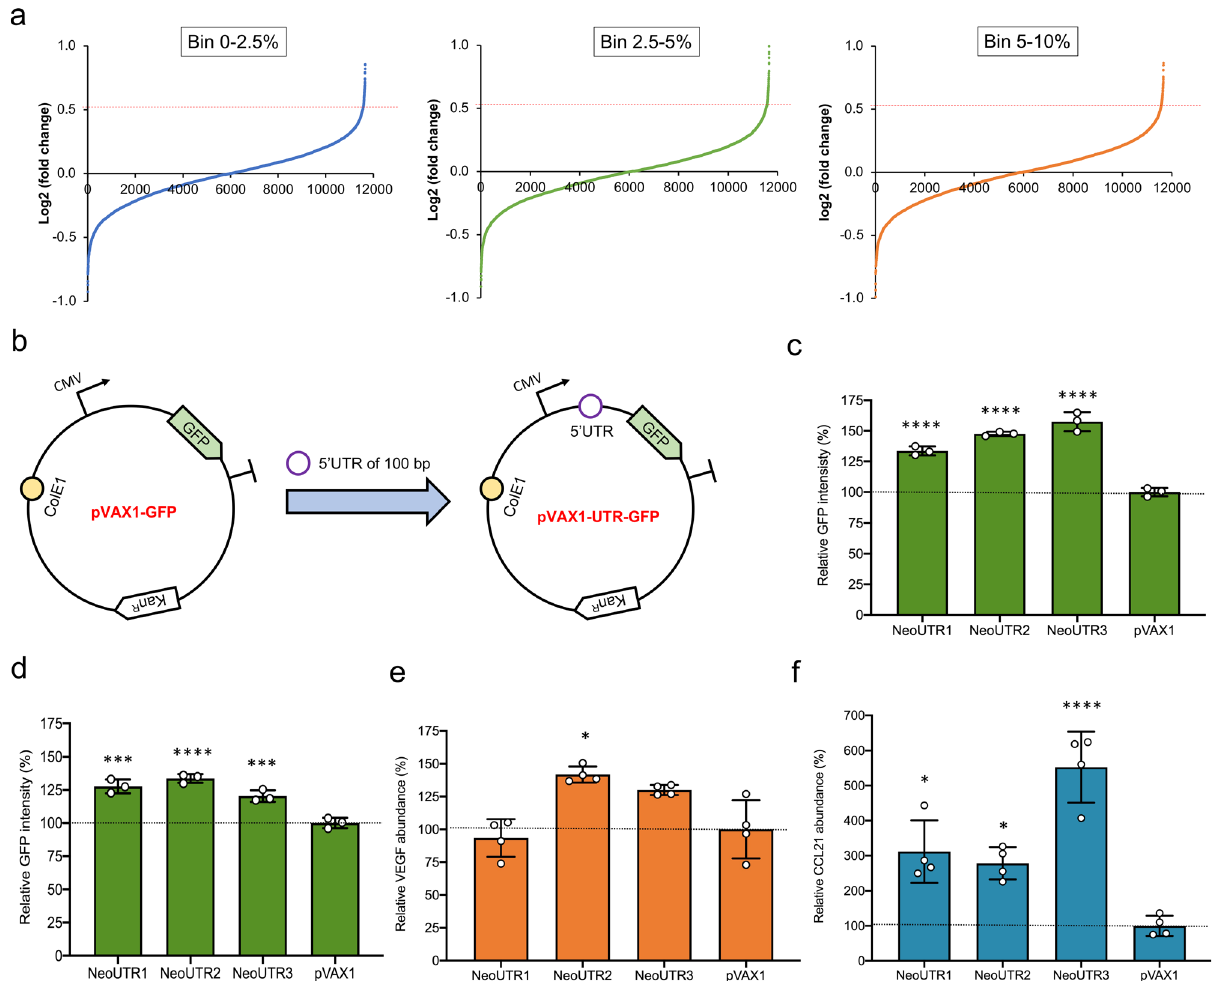
Fig. 4 Selection and validation of 5 ′ UTR candidates. a 5 ′ UTRs that modulate protein expression were ranked by their mean log2 ratios (compared with the control of unsorted cells) of the normalized barcode count in the three bins based on GFP expression. 5 ′ UTRs with a log2 ratio greater than 0.52 (which is highlighted as a red dotted line) in all three bins were selected for further validation. b The GFP gene was inserted into the pVAX1 plasmid to make the pVAX1-GFP plasmid, which was used as a control in the GFP expression study. 5 ′ UTR candidates were inserted directly upstream of the Kozak sequence of the GFP coding sequence to make the pVAX1-UTR-GFP plasmids. c Three 5 ′ UTR candidates that signi fi cantly enhanced protein expression were chosen for further testing. The p -values for NeoUTR1, NeoUTR2, NeoUTR3 vs pVAX1 are <0.0001, <0.0001, and <0.0001. d The effects of the three 5 ′ UTRs on GFP expression in RD cells. The p -values for NeoUTR1, NeoUTR2, NeoUTR3 vs pVAX1 are 0.0001, <0.0001 and 0.0010. e The effects of the three 5 ′ UTRs on VEGF expression in RD cells. The p -values for NeoUTR1, NeoUTR2, NeoUTR3 vs pVAX1 are 0.8838, 0.0146 and 0.0675. f The effects of the three 5 ′ UTRs on CCL21 expression in RD cells. The p -values for NeoUTR1, NeoUTR2, NeoUTR3 vs pVAX1 are 0.0183, 0.0412, and 0.0002. Relative protein expression in each sample was normalized to that of the pVAX1 plasmid (relative expression (%) = 100 is highlighted as a gray dotted line). Source data are provided as a Source data fi le. Statistical differences between groups were analyzed by ordinary one-way ANOVA with 95% con fi dence interval. Data are presented as mean values ± SD for three biological replicates ( c , d ) or four biological replicates ( e , f ). (* p < 0.05; ** p < 0.01; *** p < 0.001; **** p < 0.0001 vs